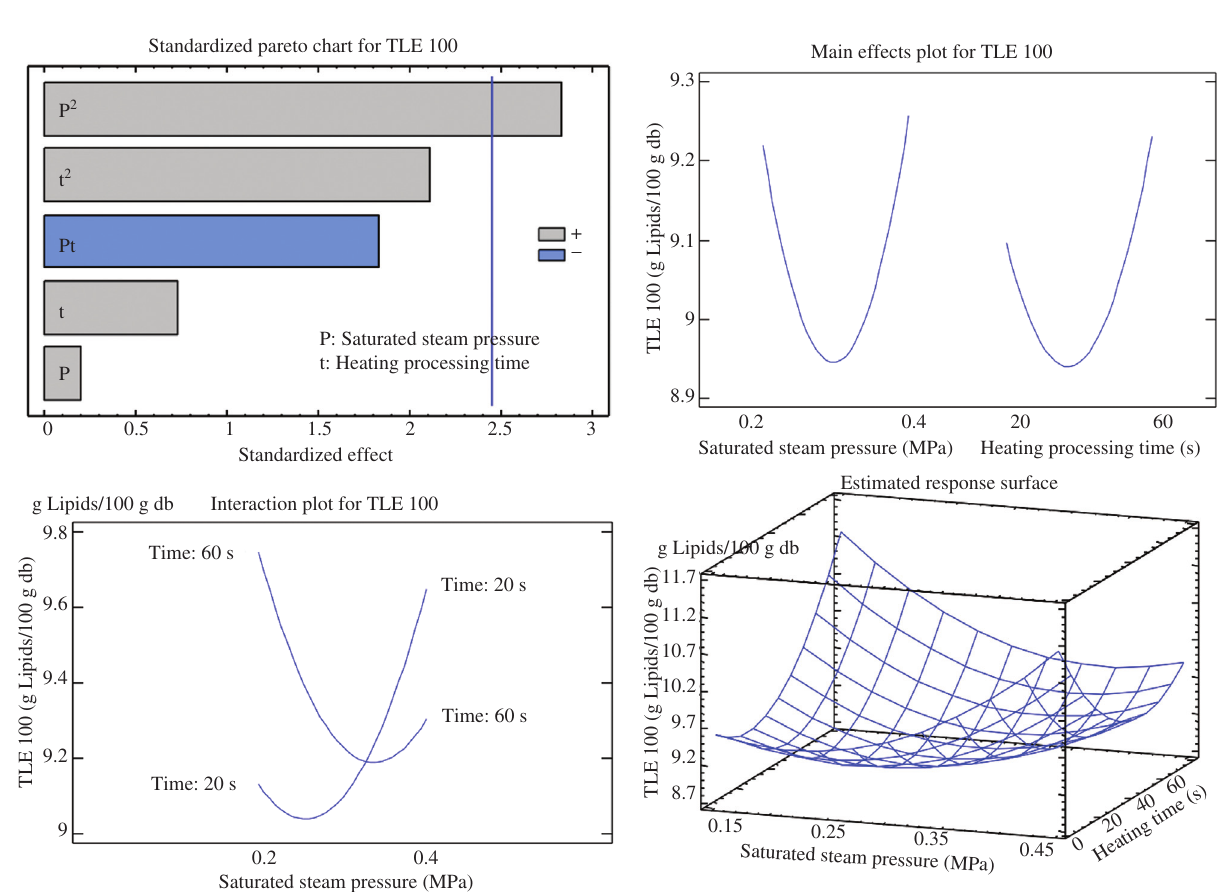
Figure 2 Pareto chart, general trends, cross effects and response surface of instant controlled pressure drop ( DIC) operating parameters for total lipids extracted after DIC treatment of microalgae (initial water content 100%